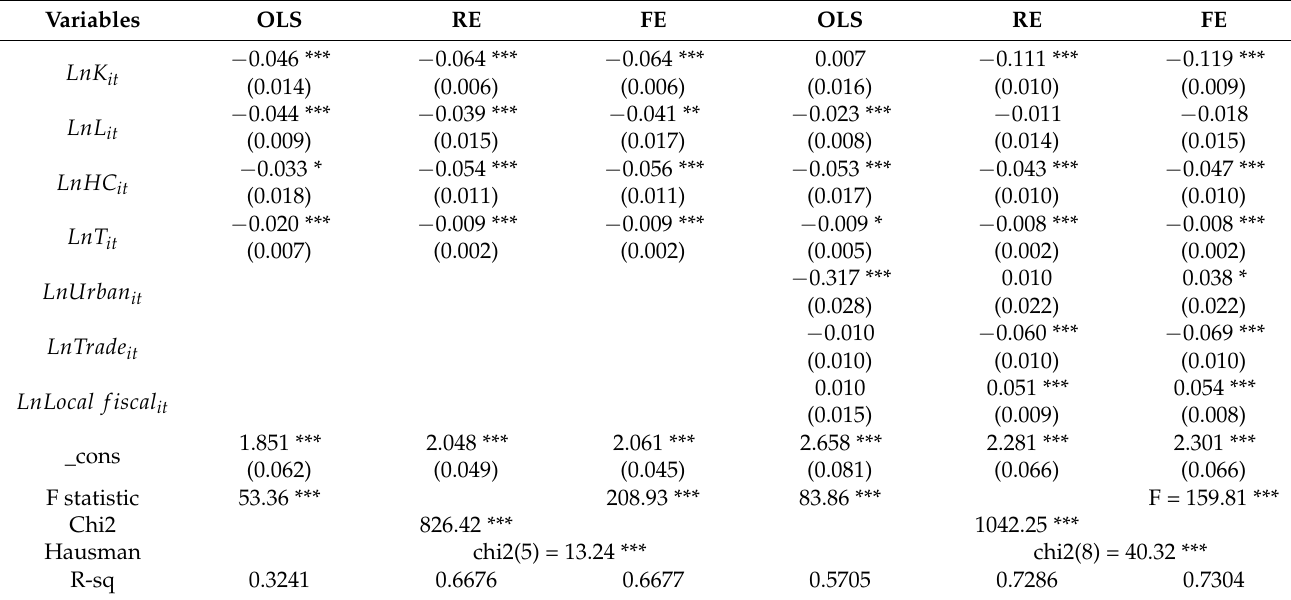
Table 4. Analysis of the poverty reduction effect of internal development factors of agricultural products circulation